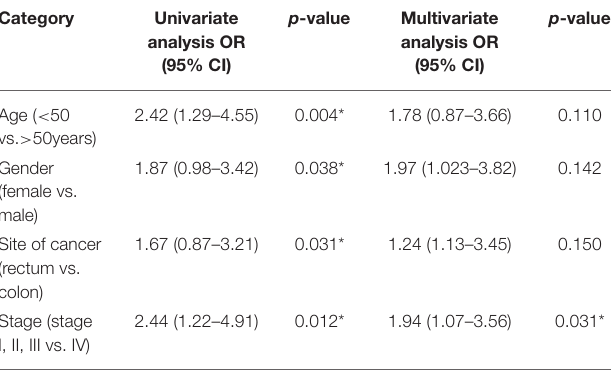
TABLE 4 | Univariate and multivariate logistic regression analysis of low vs. normal 25-OH VD level ( ≤ 15 vs. > 15ng/ml). Category